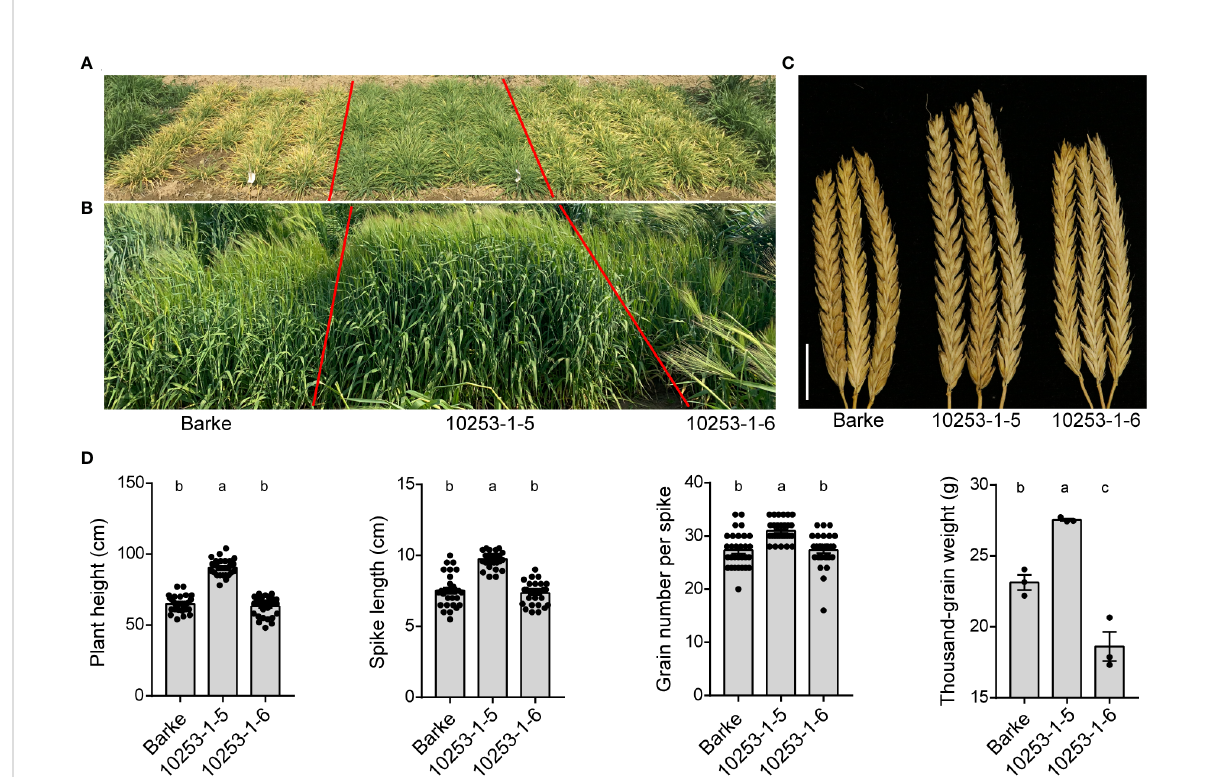
FIGURE 5 Trials of EMS-induced pdil5-1 mutants in virus-prevalent fi elds. Three independent plots per genotype were analyzed. (A) Assessment of the pdil5-1 mutant (10253-1-5), its sibling line (10253-1-6), and the parental line ‘ Barke ’ for disease resistance in a disease nursey in Yancheng, Jiangsu Province (2020-2021). The photograph was taken at the end of February at the tillering stage. (B) The latter two genotypes show stunted growth and fewer tillers at the heading stage compared to the pdil5-1 mutant. (C) The spikes of plants grown in virus-prevalent fi elds. Scale bar = 2 cm. (D) Statistics of the agronomic performance offour traits. Statistical analysis was performed using Tukey ’ s post hoc ANOVA ( p < 0.05); different letters on bars indicate statistically signi fi cant differences. For plant height, spike length, and grain number per spike, 30 plants per genotype were analyzed. Thousand-grain weight was measured based on the performance of three plots per genotype. Error bars =